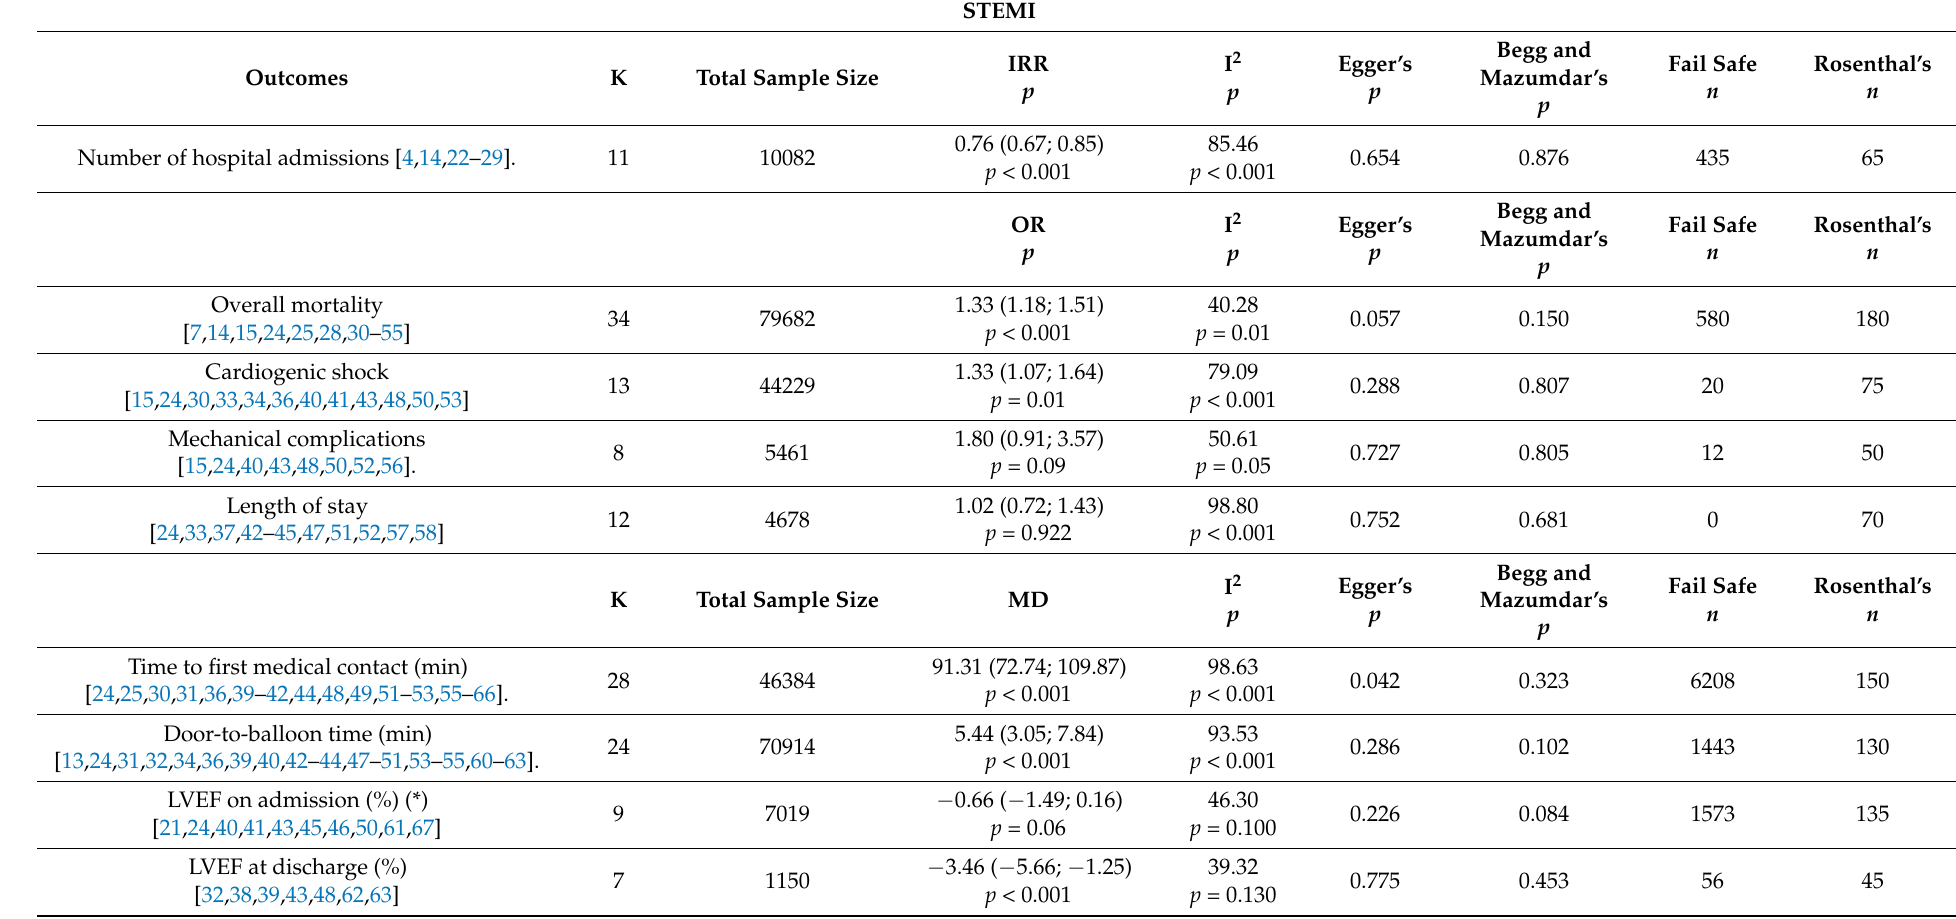
Table 1. Meta-analysis results: pandemic period 2020 versus control